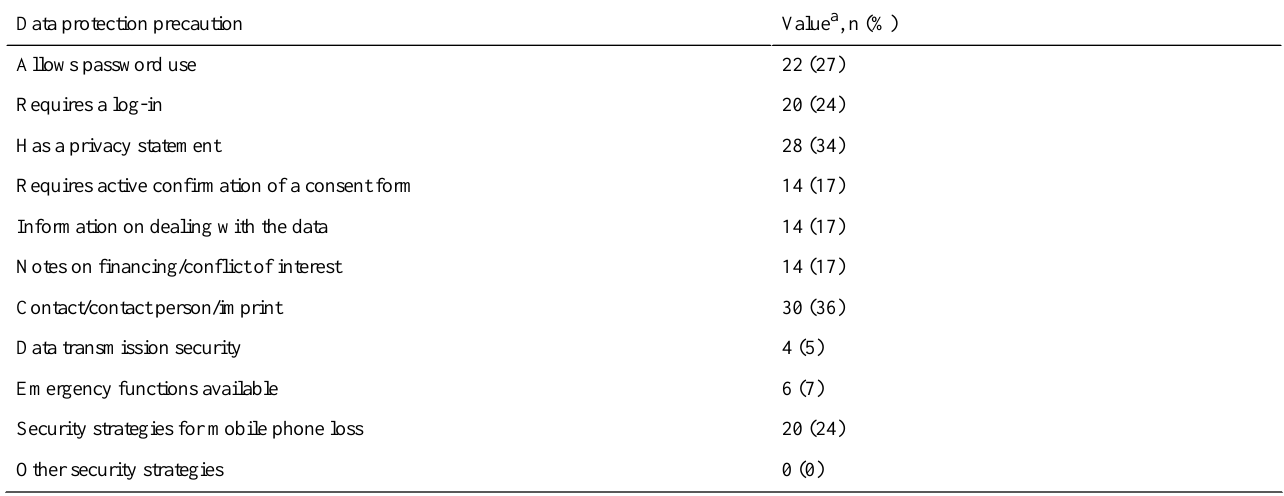
Table 2. Privacy and security measures found in mobile